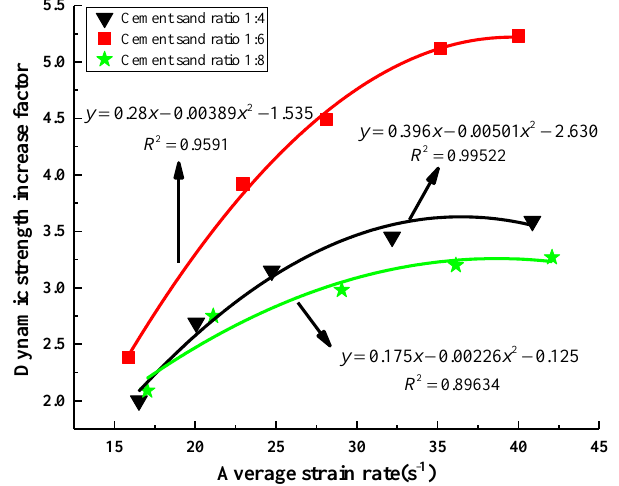
Figure 10. Relationship between dynamic strength growth factor and average strain rate.